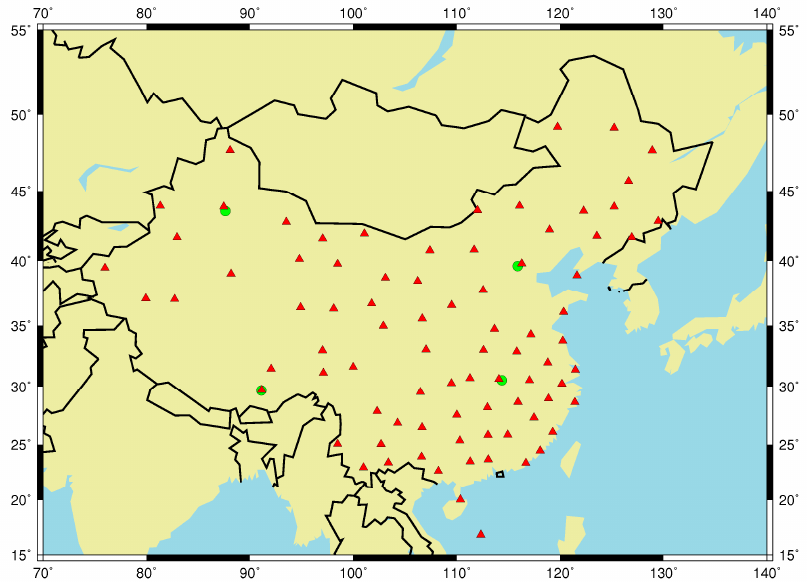
Figure 1. Geographic distribution of 81 radiosonde stations (red solid triangles) and 4 International Global Navigation Satellite System Service (IGS) stations (green solid circles).